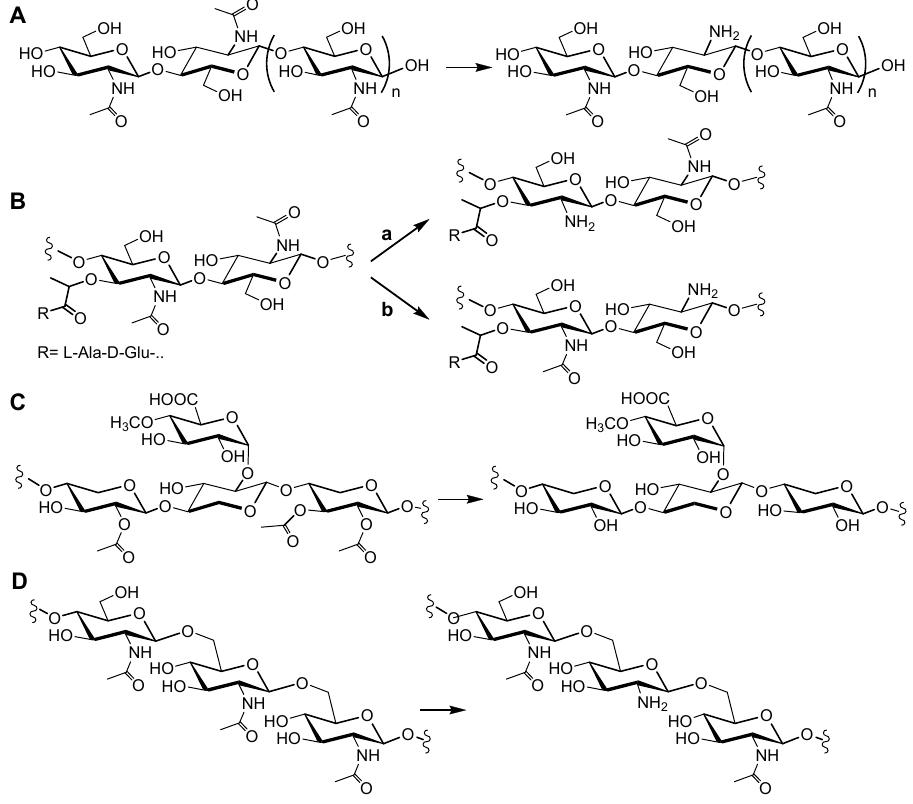
Figure 1. Structures of the substrates of CE4 enzymes and representative deacetylated products. ( A ) Chitin oligosaccharide substrate of chitin deacetylases; ( B ) Peptidoglycan fragment substrate of peptidoglycan MurNAc deacetylases (a) or peptidoglycan GlcNAc deacetylases (b); ( C ) Acetyl- D -glucurono- D -xylan substrate of acetylxylan esterases; ( D ) β -1,6-Glucan substrate of poly- β -1,6- N -acetylglucosamine deacetylases.